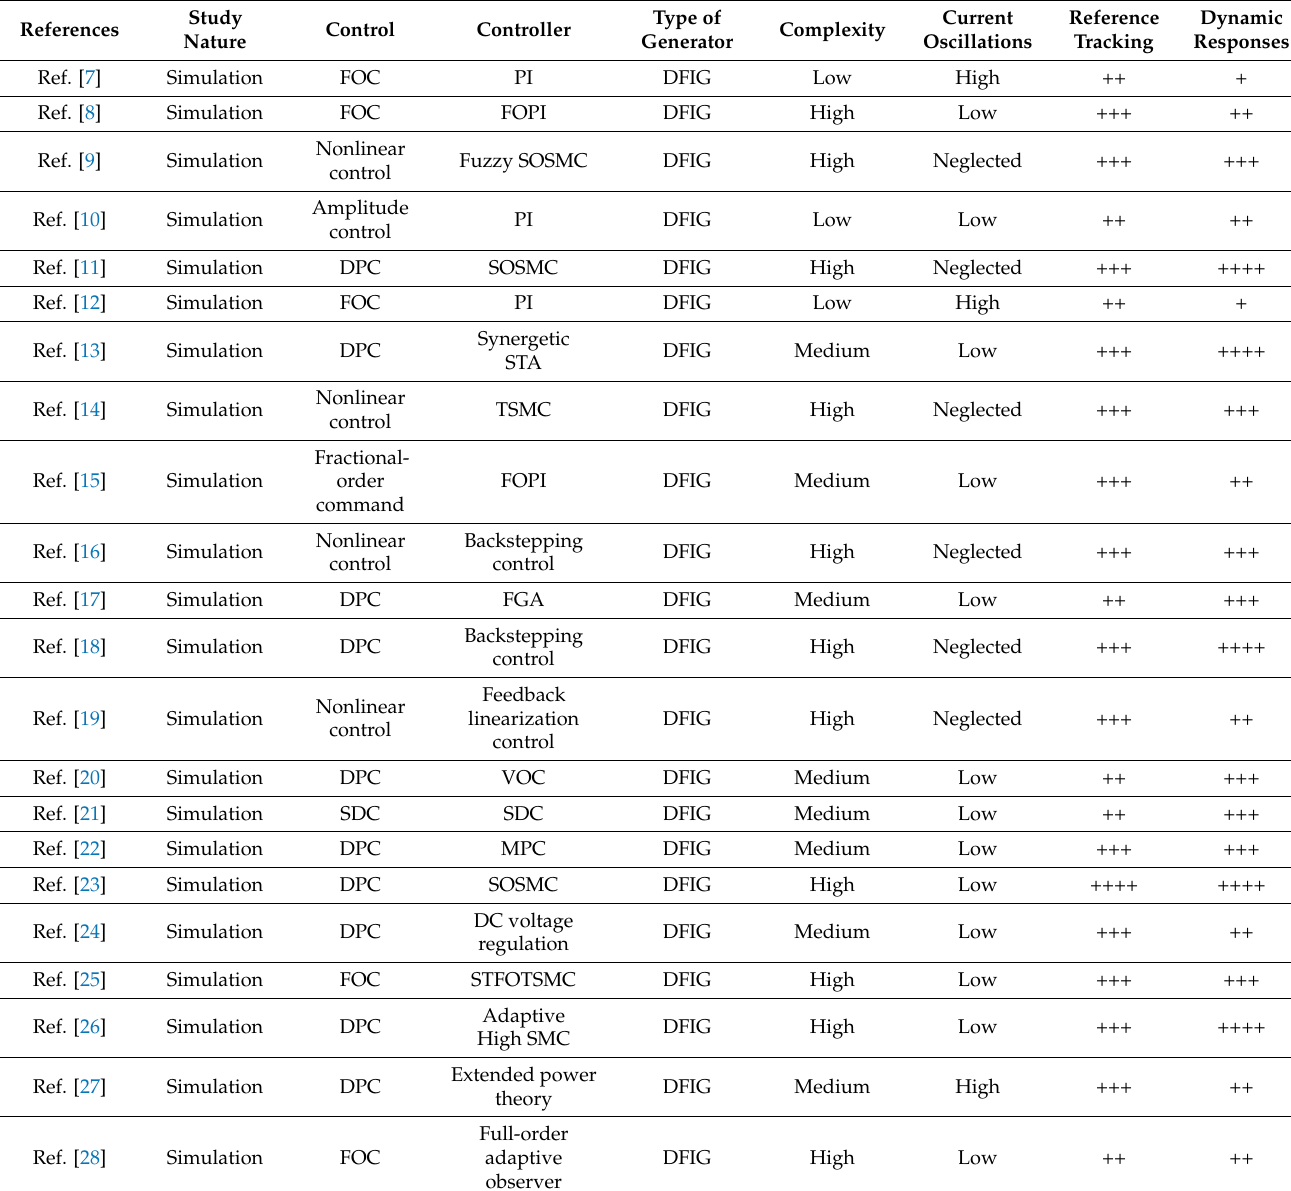
Table A1. A comparative study of different techniques based on DFIG-Wind